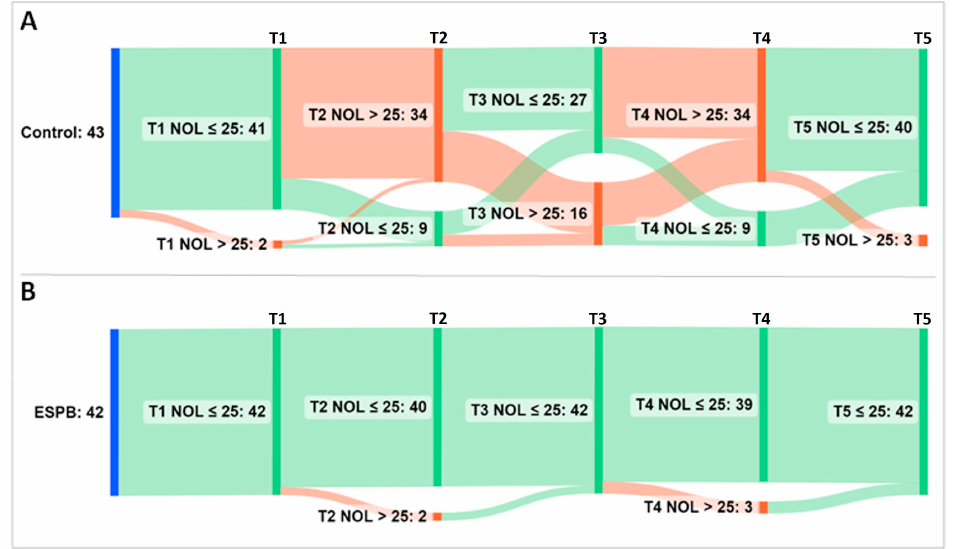
Figure 5. Alluvial diagram showing the flow of patients across five NOL index sampling time points. ( A ) Group Control; ( B ) Group ESPB. The sampling was performed at pre-incision (T1), post-incision (T2), pre-sternotomy (T3), post-sternotomy (T4), and pre-CPB (T5). Time points accompany vertical bars connected by stripes. The cumulative height of the bars per time point is constant within a group and encodes the total number of patients in the group (i.e., 43 patients in the Control and 42 patients in the ESPB group). The height of the stripes encodes the number of patients that shift from one bar to the next. As they leave their source bar, the stripes pick up the color of their target bar. The color of bars and stripes encodes either a non-nociceptive response (i.e., green for NOL index ≤ 25) or a nociceptive response (i.e., red for NOL index > 25) to noxious stimuli. The first bar (blue) encodes patients at baseline. Most of the ESPB patients exhibited a steady NOL index ≤ 25. Conversely, the control group achieved late nociception control at the additional cost of more fentanyl administration than the interventional group. Abbreviations: ESPB, erector spinae plane block; NOL, nociception level.